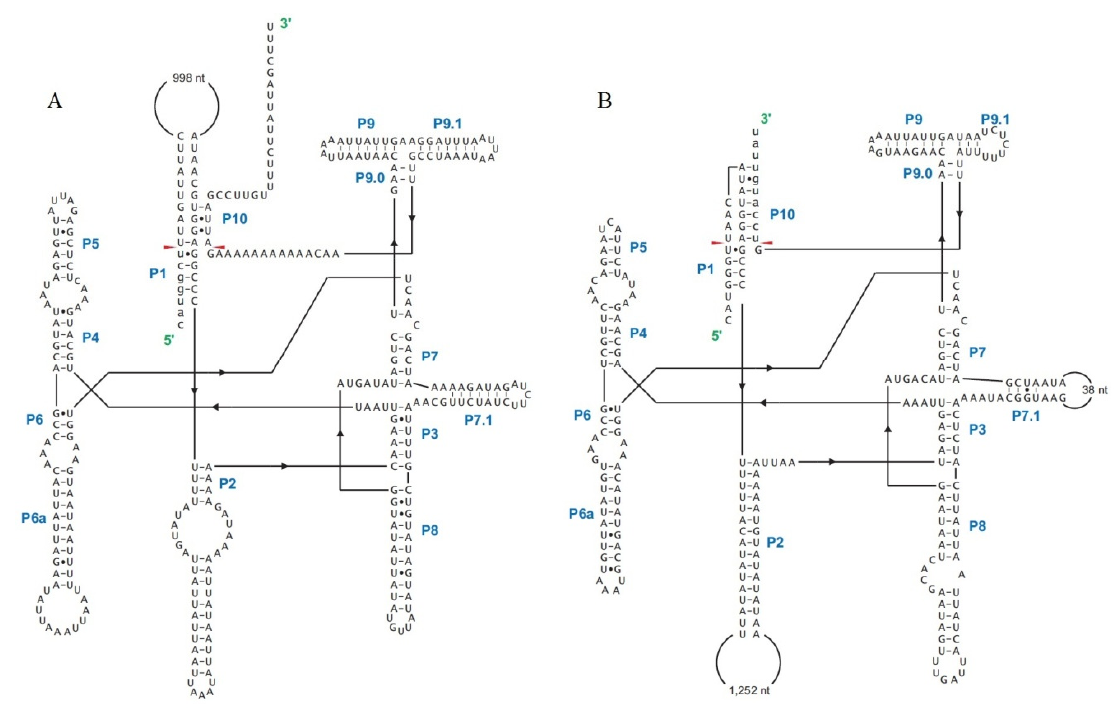
Figure 6. Predicted RNA secondary structures for upstream ( A ) and downstream introns ( B ) in cox3 ‐ i2. The 10 pairing regions (P1–P10) are indicated. The structure of the upstream intron is presented based on 1–1332 bp of cox3 ‐ i2 and seven base pairs of its upstream exon (lower cases in 5 ′ end of A ); and the structure of the downstream intron is presented based on base pairs 1333–2887 of cox3 ‐ i2 and ten base pairs of its downstream exon (lower cases in 3 ′ end of B ). Seven base pairs in the 5 ′ end of B (shown by lower case) are supposed to be a part of the upstream intron. The red arrows indicate the intron/“exon” junctions. The locations of corresponding homing endonuclease genes (HEG) are shown in the Figure. The HEG of upstream intron locates in its P1 loop; and that of downstream intron is in P2 loop. The models shown in the figure were assembled by combining the programs INFERNAL [29], Mfold [30], and Corel Draw™ ( Corel Corporation: Ottawa, Canada ).